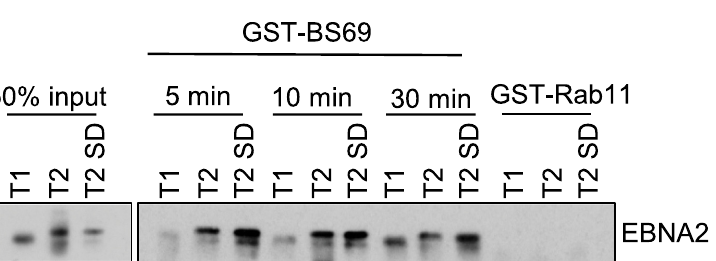
Fig 6. GST pulldown assay using GST-BS69 CC-MYND and lysates from B cell lines expressing type 1 and type 2 EBNA2. Nuclear extracts of Daudi:pHEBo-MT:EBNA-2 cells expressing type 1 (T1), type 2 (T2) or type 2 SD EBNA2 proteins were incubated for 5, 15 or 30 min at 4˚C with glutathione beads which had been loaded with bacterial lysates expressing the GST- BS69 CC-MYND . GST-RAB11B was used as a negative control and was incubated for 30 min with the nuclear extracts. Following washing, beads were resuspended in protein sample buffer and analysed by SDS-PAGE and Western blotting for EBNA2 using the PE2 anti-EBNA2 antibody. The EBNA2 proteins expressed by these cell lines display almost the same size (72 kD) since the number of polyproline residues had been equalised in all the EBNA2